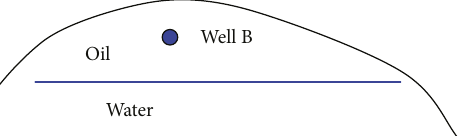
Figure 27: The plan view of well B. This oil reservoir is an anticline reservoir.